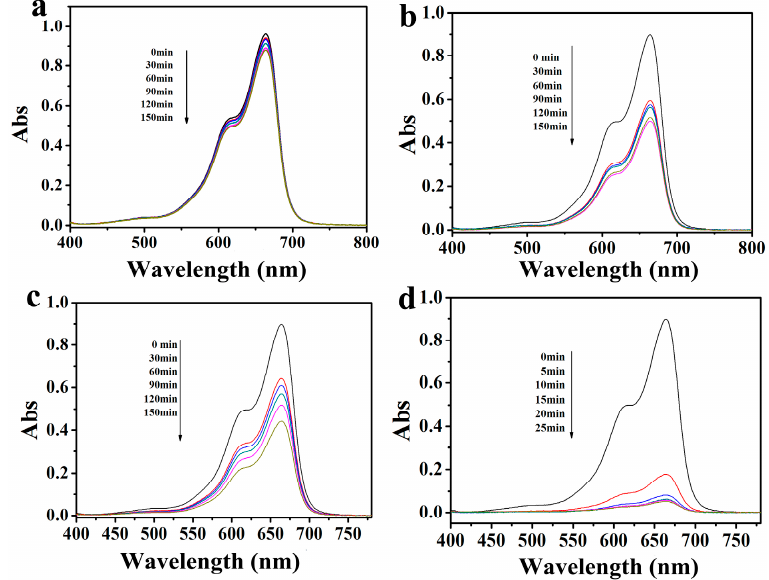
Figure 6. Changes to the absorbencies of the MB aqueous solutions, added by different adsorbent, in dependence of time. ( a ) added by pure BiFeO 3 ; ( b ) added by CCT adsorbent; ( c ) added by CCT-BFO adsorbent; and ( d ) added by CT-BFO adsorbent. The MB initial concentration is 10 mg·L − 1 , the pH value of the solutions is 7.